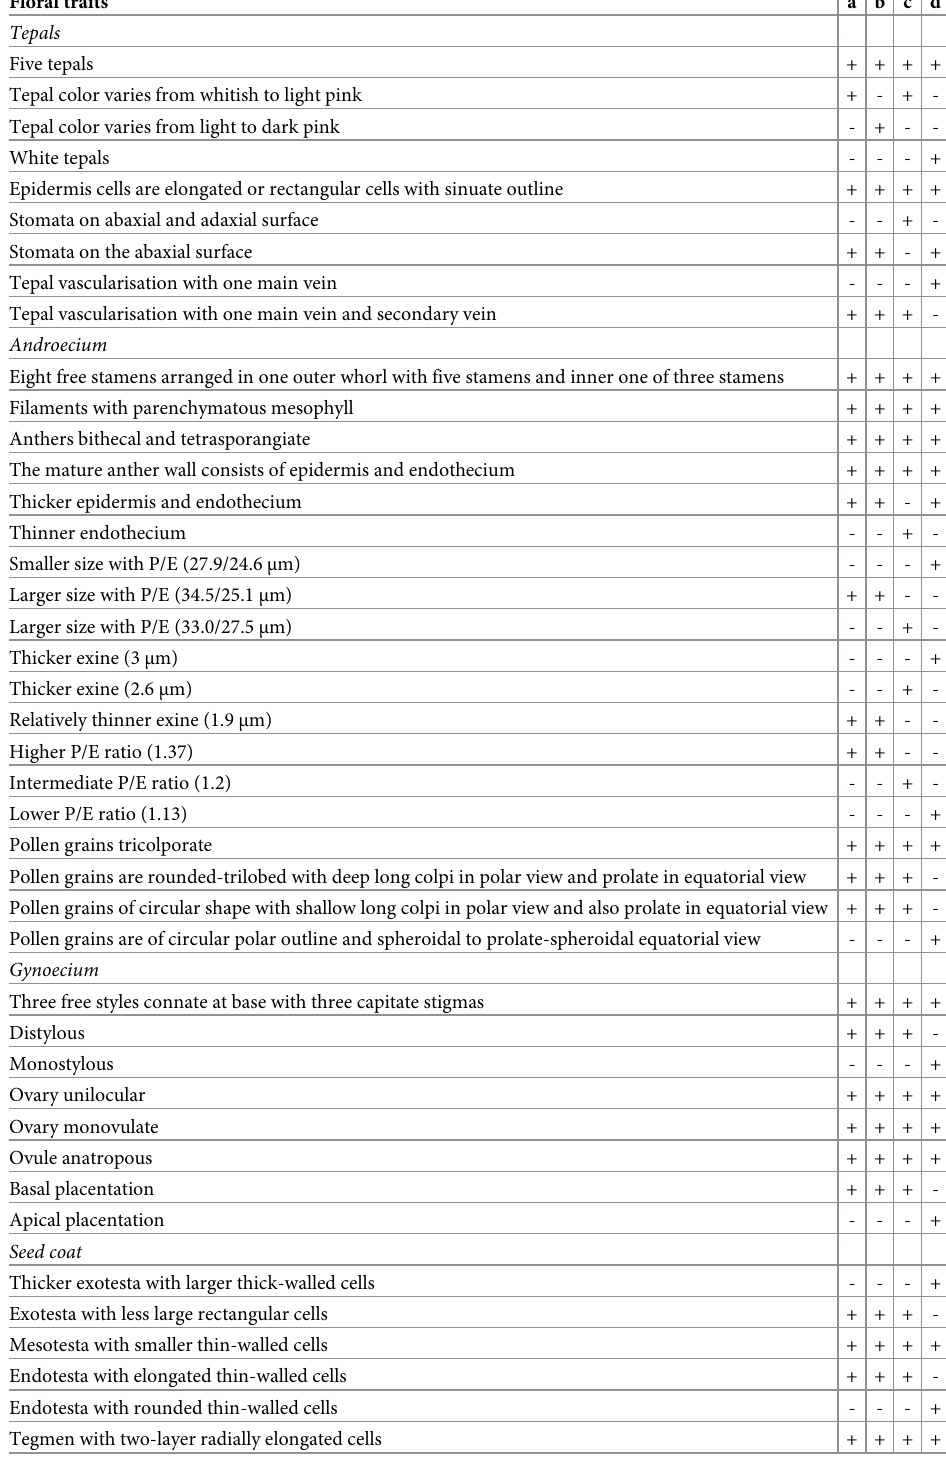
Table 3. Morpho-anatomical characteristics of the flowers of Polygonom L. species. a: P . equisetiforme var. grae- cum , b: P . equisetiforme var. peyerinhoffi , c: P . aviculare , d: P . maritimum .–absence, +